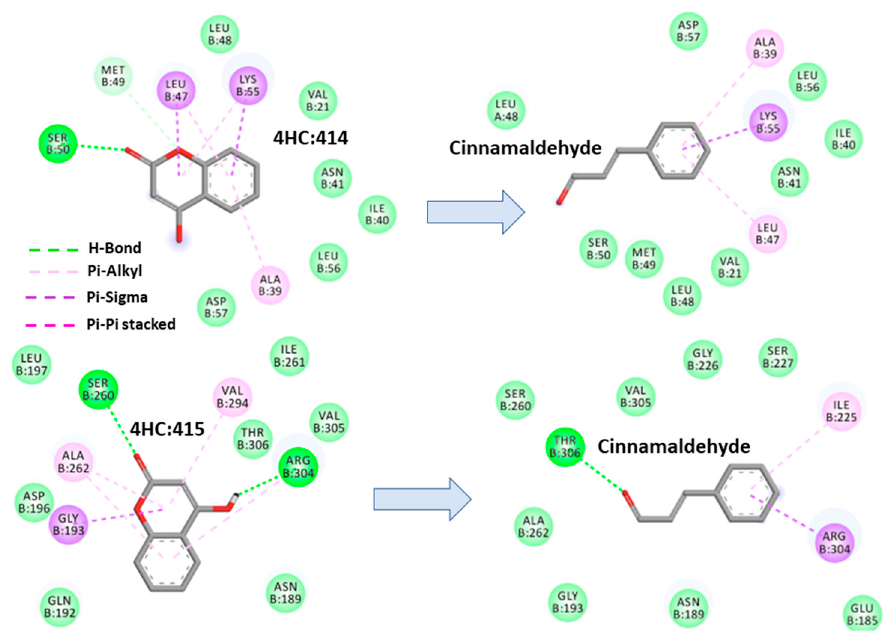
Figure 8. Binding modes for the best poses of the docked FtsZ complexes with 4-hydroxicumarin and cinnamaldehyde in the two allosteric sites. Table 3. Summary of the binding affinities of co-crystalized GDP, 4-hydroxycumarin in two differ- ent allosteric sites and cinnamaldehyde in terms of docking scores and glide energies generated by GLIDE XP docking.